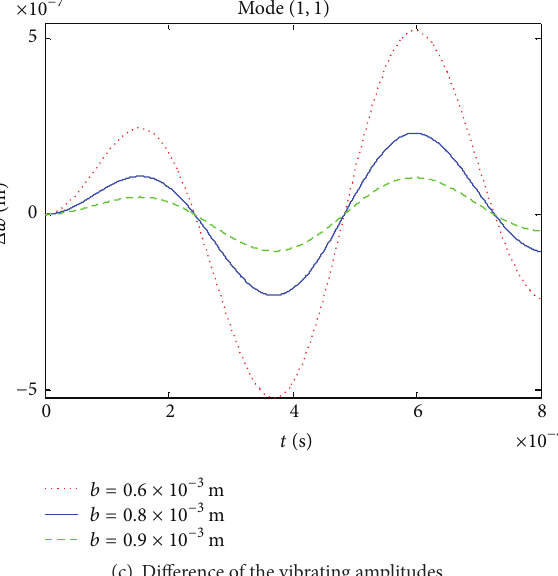
Figure 3: Effects of the van der Waals force on vibrating amplitude of the film center for various 𝑏 .